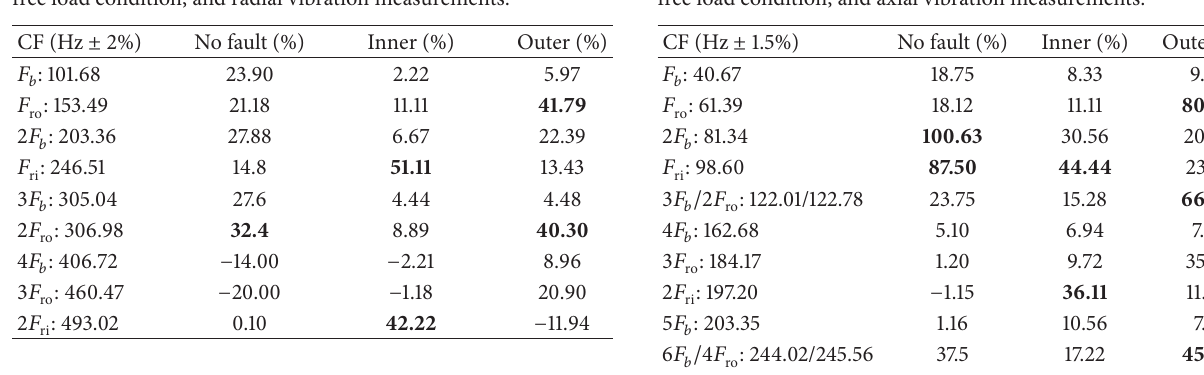
Table 4: Calculated 𝑉 Δ (𝑓 𝑖 ) s within [0, 310 Hz], 20 Hz motor input, free load condition, and axial vibration measurements.